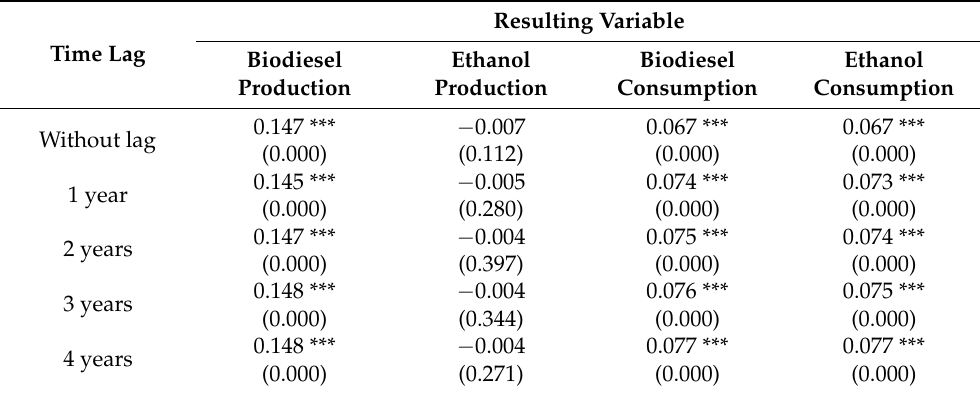
Table 6. Results of the assessment of transport taxes impact on the production and consumption of different types of biofuels in the European countries for 2010–2020.